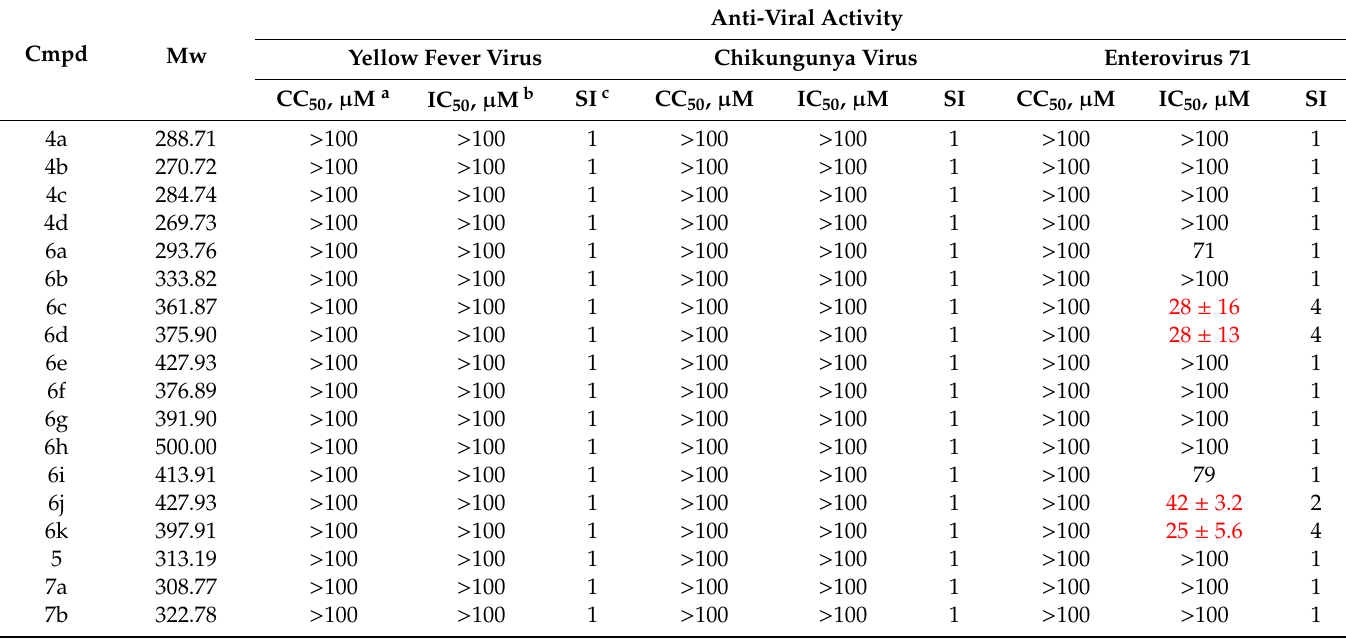
Table 3. Cytotoxic and virus-inhibiting properties of 1 (cid:48) -homocarbanucleosides analogs against Yellow Fever virus, Chikungunya virus and Enterovirus 71 in cell